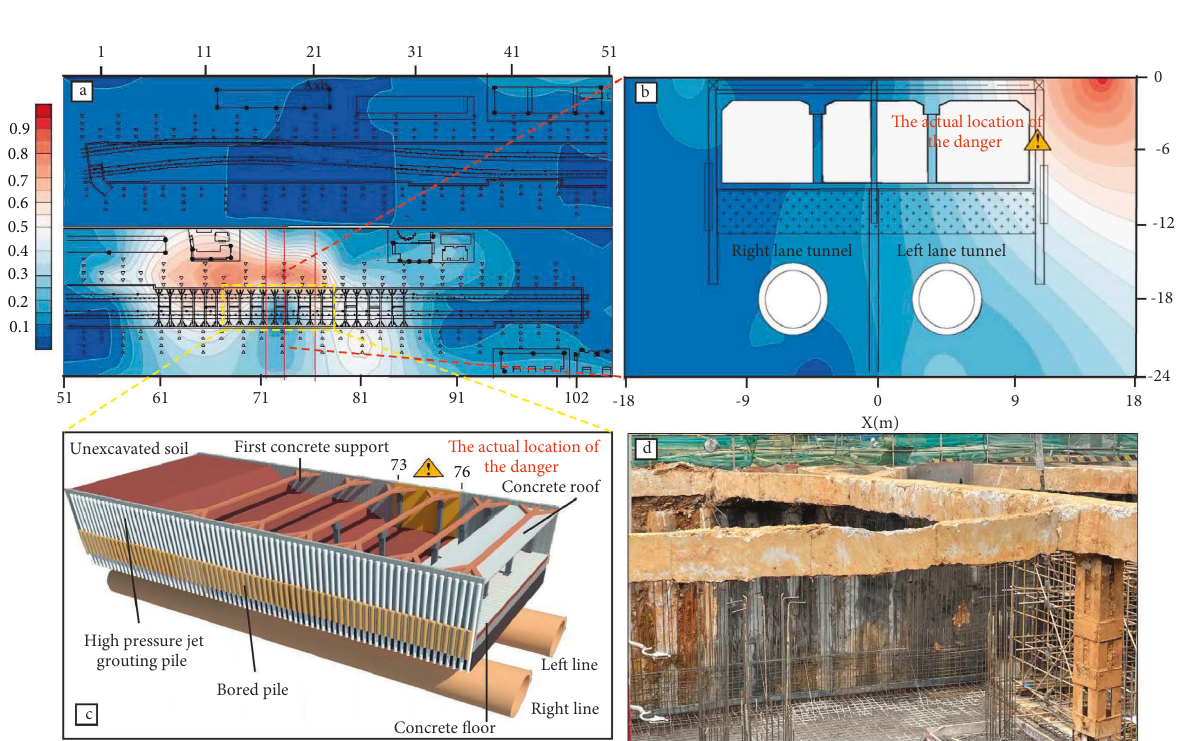
Figure 12: Comparative analysis of the first risk assessment and the actual situation: (a) risk distribution assessment plan; (b) risk distribution assessment sectional view; (c) construction status and actual location of the accident at the time of the first accident ; (d) the scene of the first